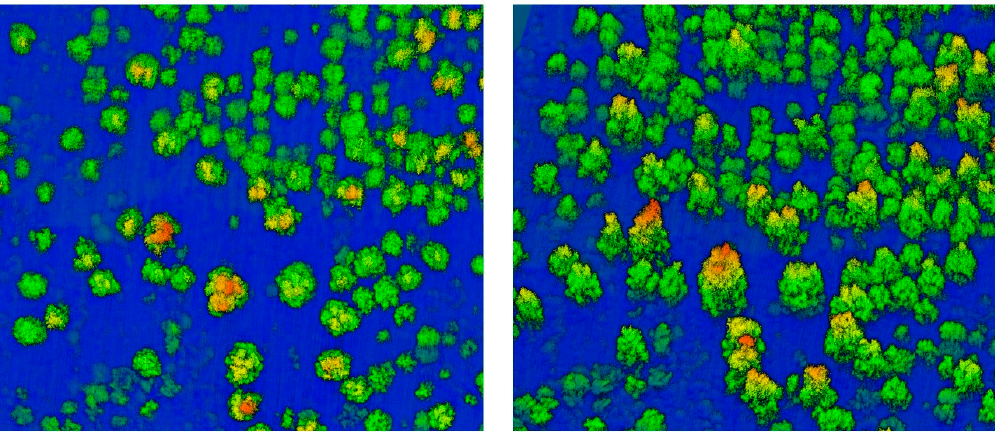
Figure 2. Example scenes of the LiDAR point cloud collected over the study site, colored by elevation (blue to red = 0–10 m). The left panel shows the bird’s eye view, while the right panel shows the isometric view.